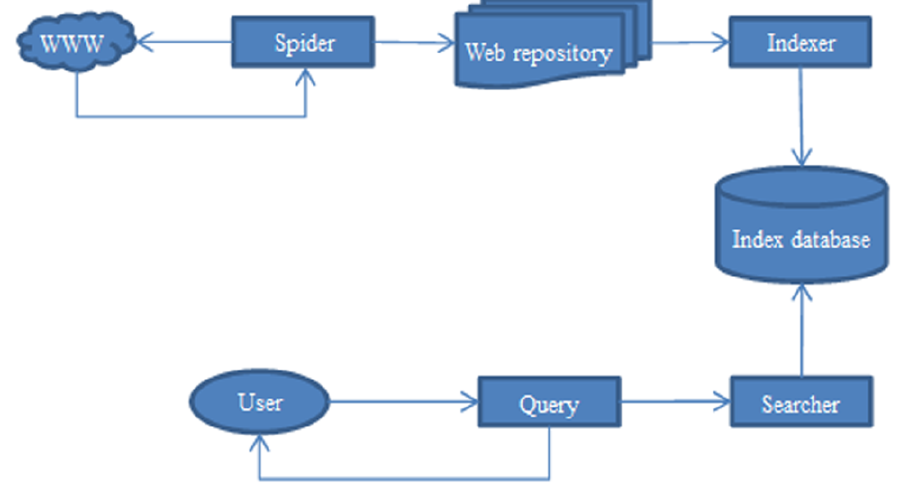
Fig. 1. Search Engine